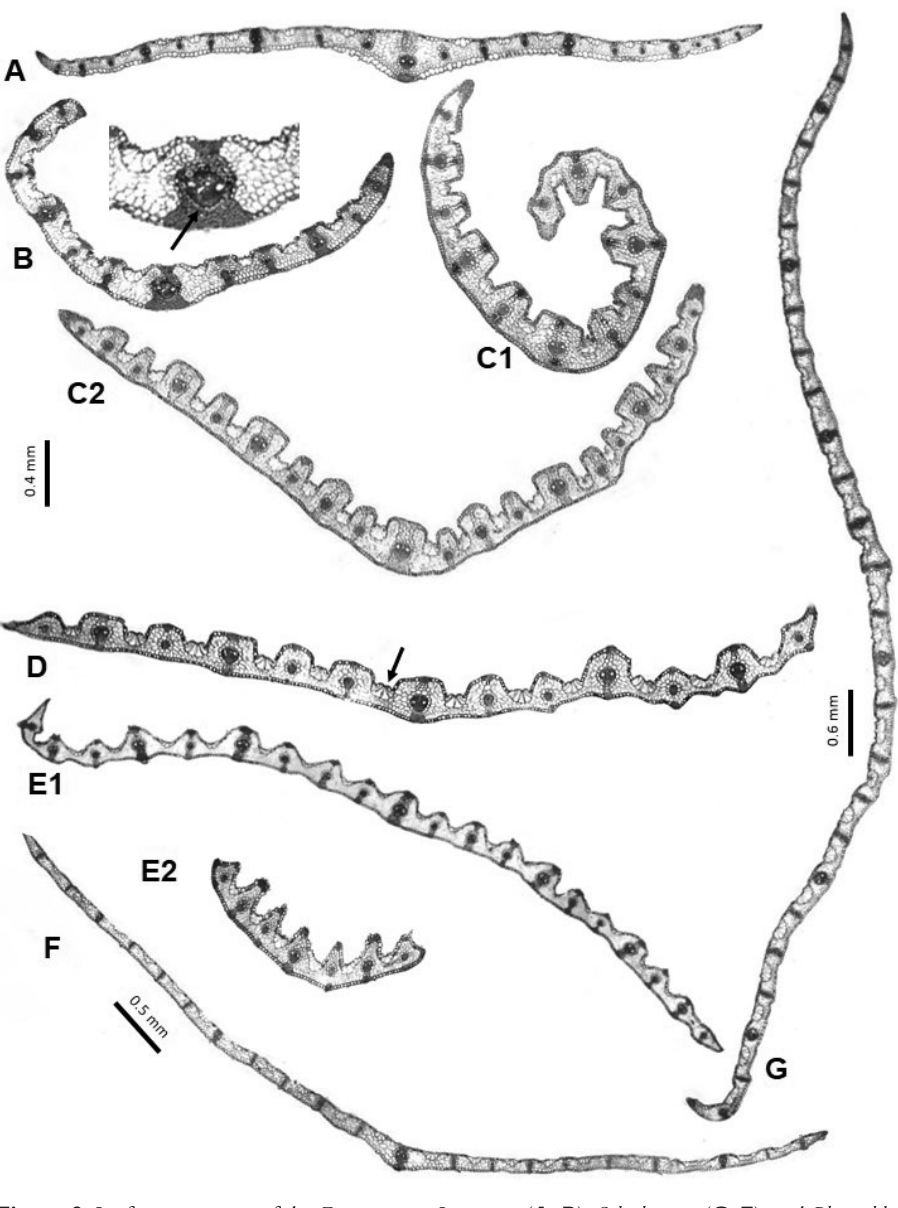
Figure 9. Leaf cross-sections of the Festuca sects. Lojaconoa ( A–B ), Schedonorus ( C–E ), and Phaeochloa ( F – G ) species. A F. patula B F. coerulescens (arrow pointing to the sclerenchyma interrupting the cells of the outer median vascular bundle sheath) C F. interrupta ( C1 inrolled leaf, C2 flat leaf) D F. arundinacea (arrow pointing to the bulliform cells) E F. mediterranea ( E1 mature leaf, E2 inmature leaf) F F. altissima G F. lasto . Scale bars: 0.4 mm ( A–E ), 0.5 mm ( F ), and 0.6 mm ( G